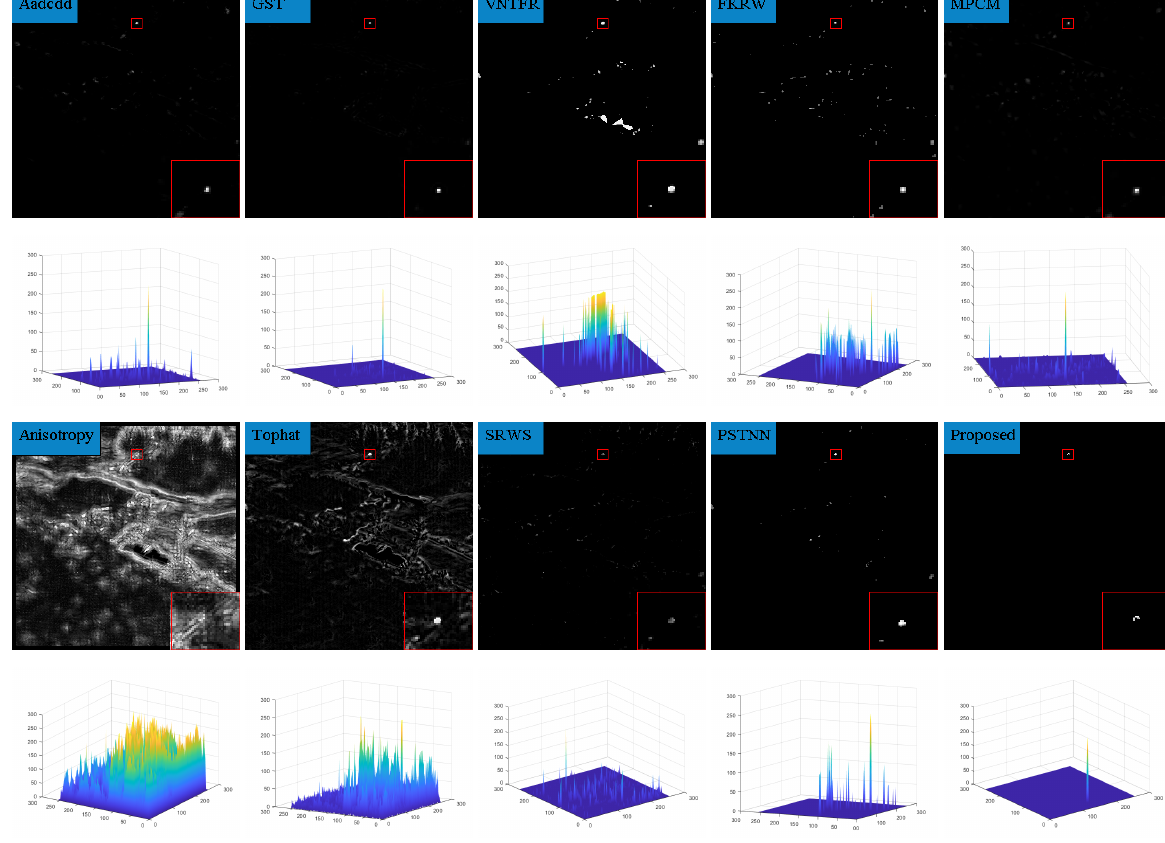
Figure 9. Detection results of sequence 1.